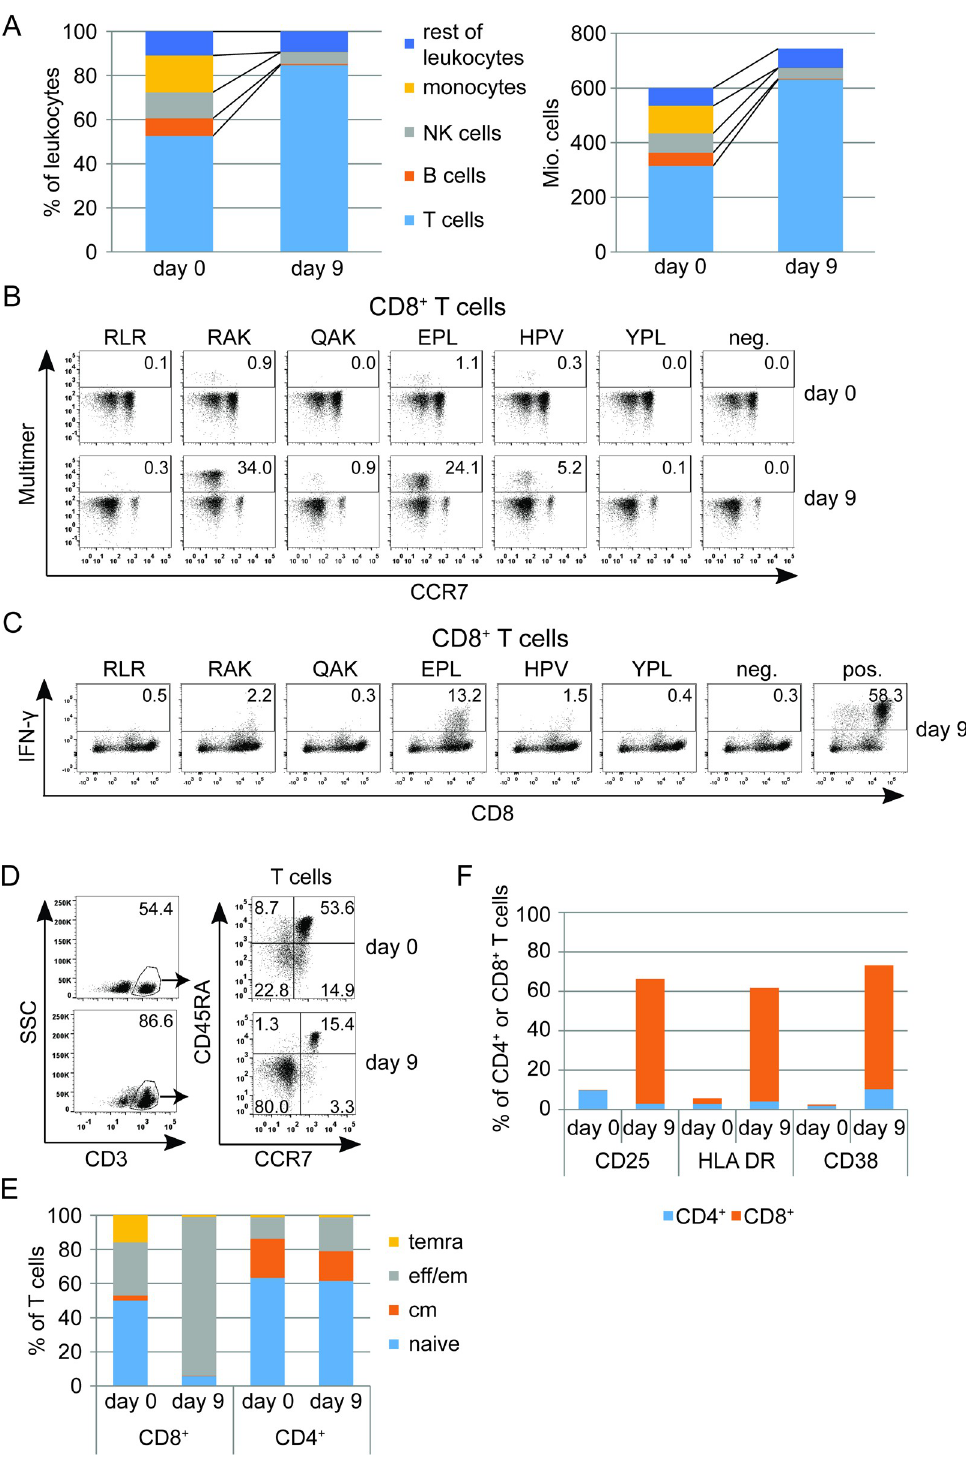
Fig 1. Manufacture of EBV-specific T cells. (A) Composition of the apheresis product that served as starting material (day 0) and the resulting T cell culture after stimulation with EBV peptides (day 9). Left panel: Proportions of different cell types in CD45 + cells (monocytes: CD14 + SSCl ow , NK cells: CD56 + , B cells: CD19 + , T cells: CD3 + , rest of leukocytes). Right panel: Composition in absolute cell numbers. (B) Percentage of peptide-specific T cells assessed by flow cytometry using peptide-MHC multimers (RLR, HLA-A � 03:01; QAK, RAK, HLA-B � 08:01; YPL, HPV, EPL, HLA-B � 35:01) on day 0 and